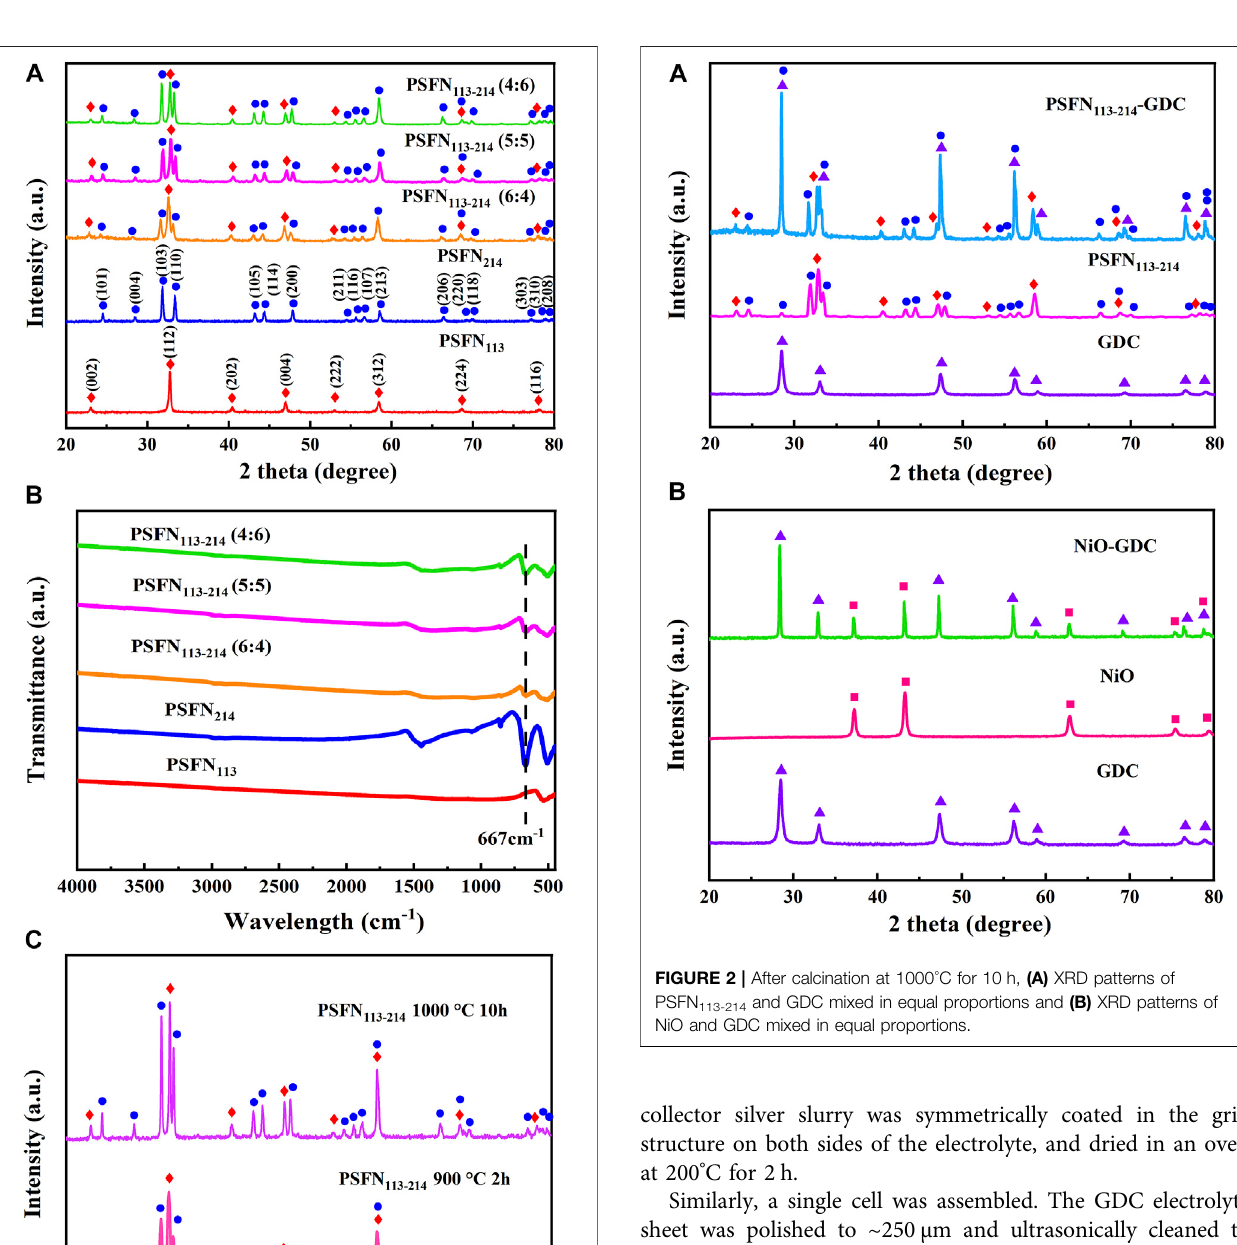
Frontiers in Chemistry |